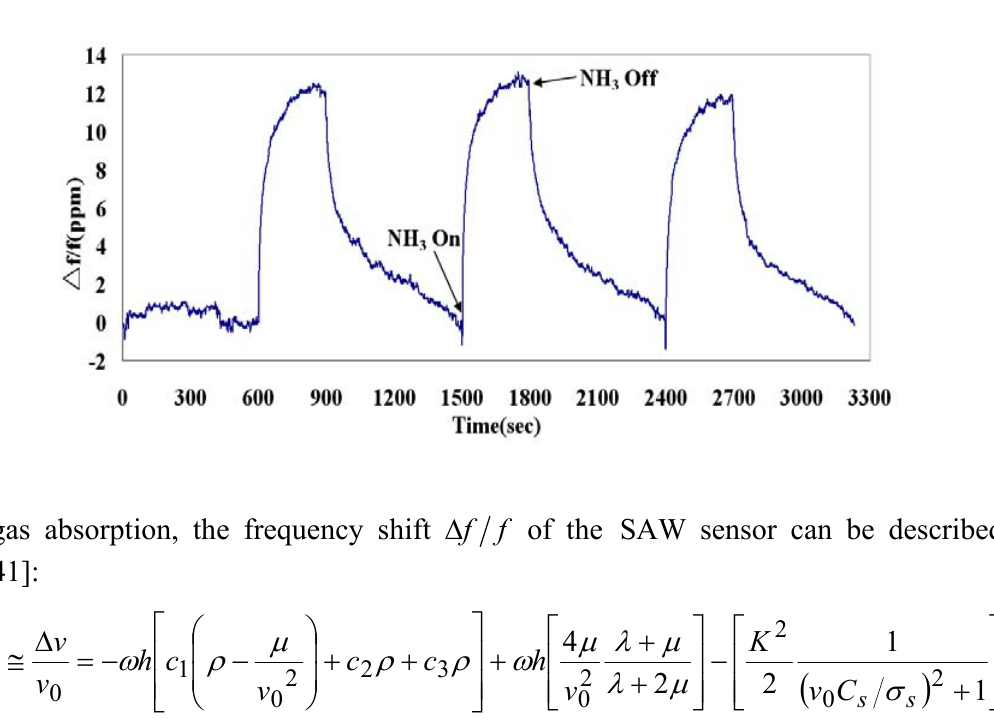
Figure 9. Frequency responses of the SAW sensor to 40 ppm